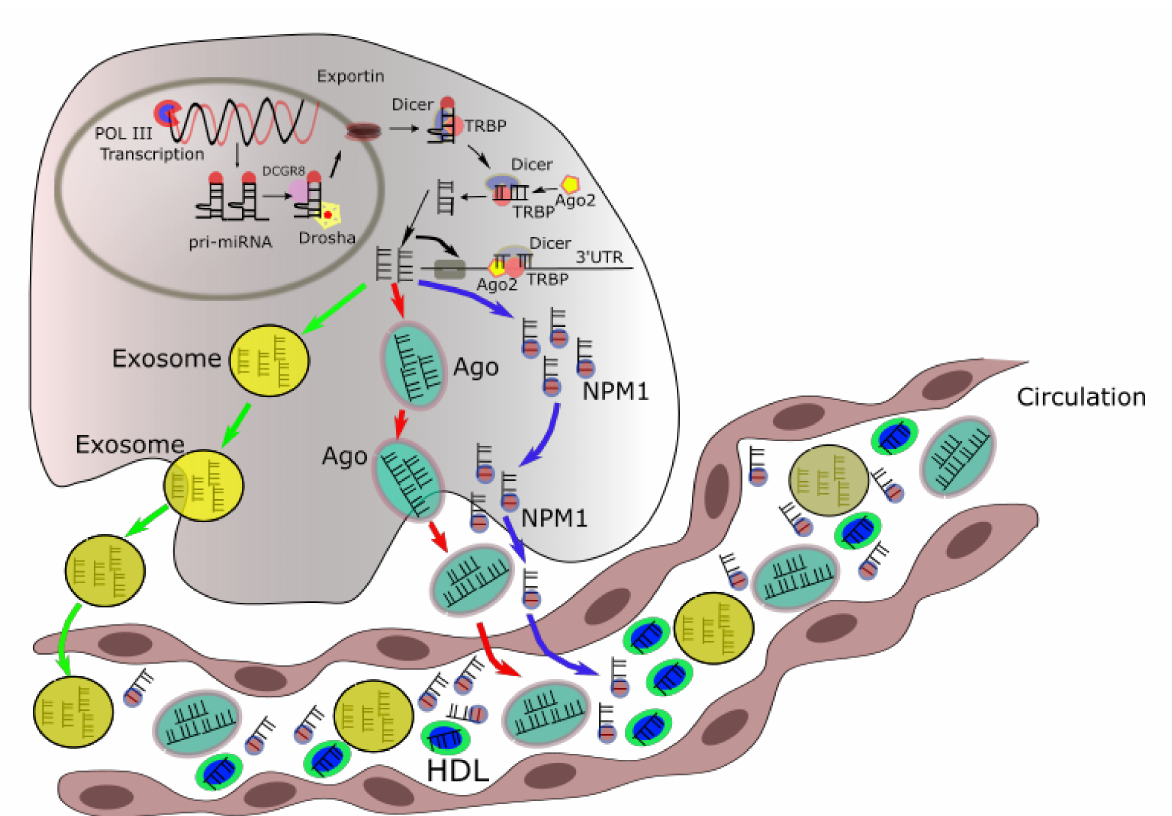
Figure 1. miRNA biogenesis and extracellular export. MicroRNAs are first transcribed by RNA polymerase II as primary (pri-miRNA) transcripts in the nucleus. The pri-miRNA are cut by the Drosha/DGCR8 complex to pre-miRNA precursors that transport into the cytoplasm by Exportin. In the cytoplasm, pre-miRNAs are further cut by Dicer in a complex with TRB, resulting the miRNA duplex. The mature miRNA incorporates with an AGO protein forming miRISC complex which will interact with the target mRNA and suppress its expression. Three ways that miRNAs can be undergone into circulation: mediated by extracellular vesicles (exosomes) (green arrows) or other RNA-binding proteins such as Ago (red arrows) or NPM1 (blue arrows). HDL, high-density lipoprotein. NPM1, nucleophosmin 1. POL III, RNA polymerase. TRB, T cell receptor